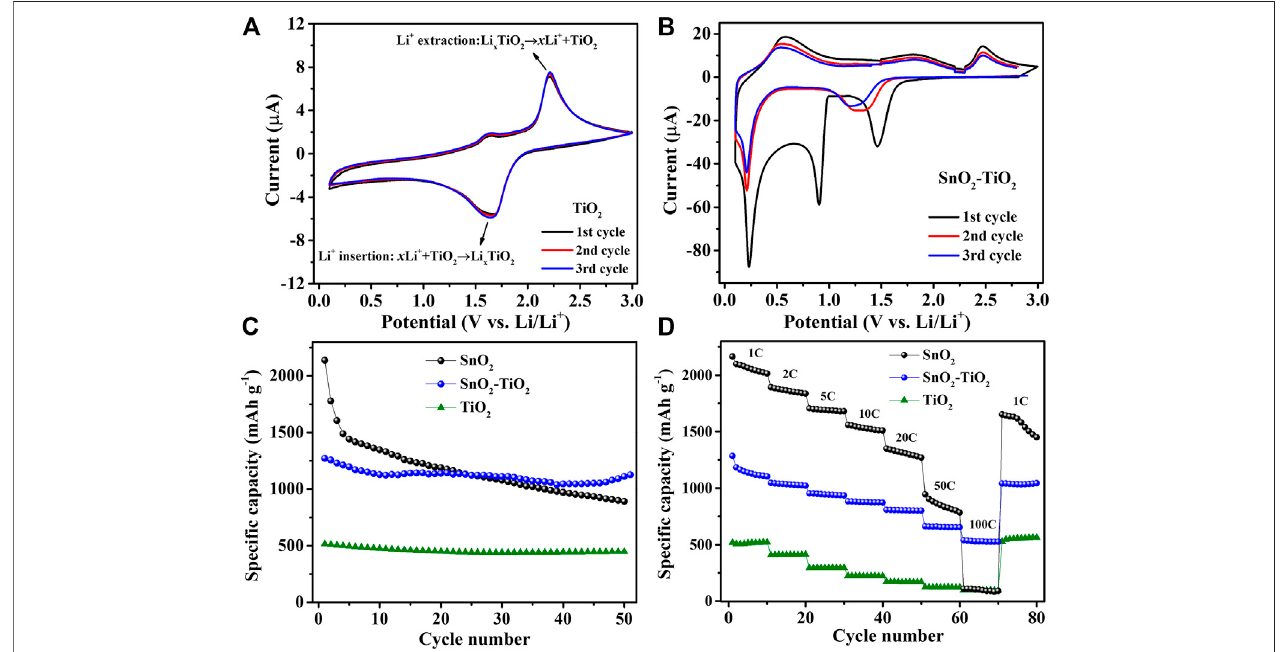
FIGURE 4 | CV curves of (A) TiO 2 and (B) SnO 2 – TiO 2 composite electrodes. The comparison of SnO 2 , TiO 2 and SnO 2 – TiO 2 composite electrode: (C) cycling performance at 1C and (D) rate performance from 1 to 100 C.